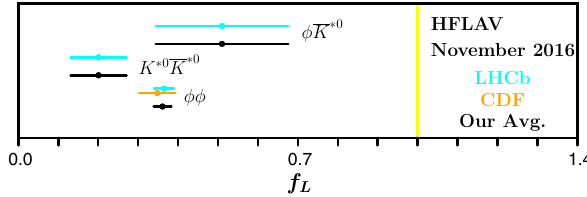
Fig. 190 Longitudinal polarization fraction in charmless B 0 s